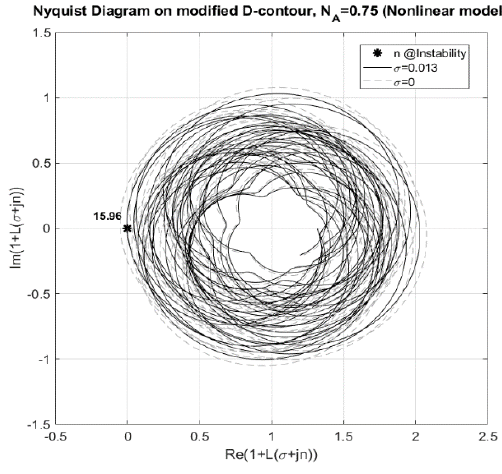
Fig. 8. Nyquist diagram with modified D-contour for NA=0.75 (for the example for γ =20°, β =10° and ν =0.38)